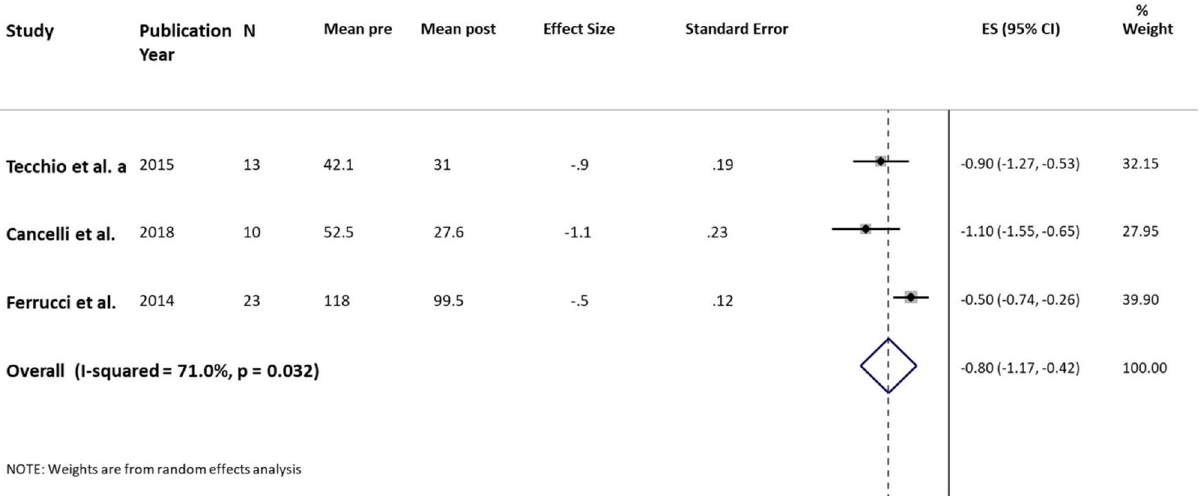
Figure 8. MS Fatigue. Real. Forest plot of meta-analysis results considering all studies. The diamond represents the pooled standardized mean difference (SMD, dashed red vertical line) and its 95% confidence interval; vertical solid dark line is the line of equivalence. The estimates for each study and their 95% confidence intervals are represented by a box with whiskers, the dimension of grey box is proportional to the precision of the study. Note: SE = Standard Error; ES = Effect Size. CI = Confidence